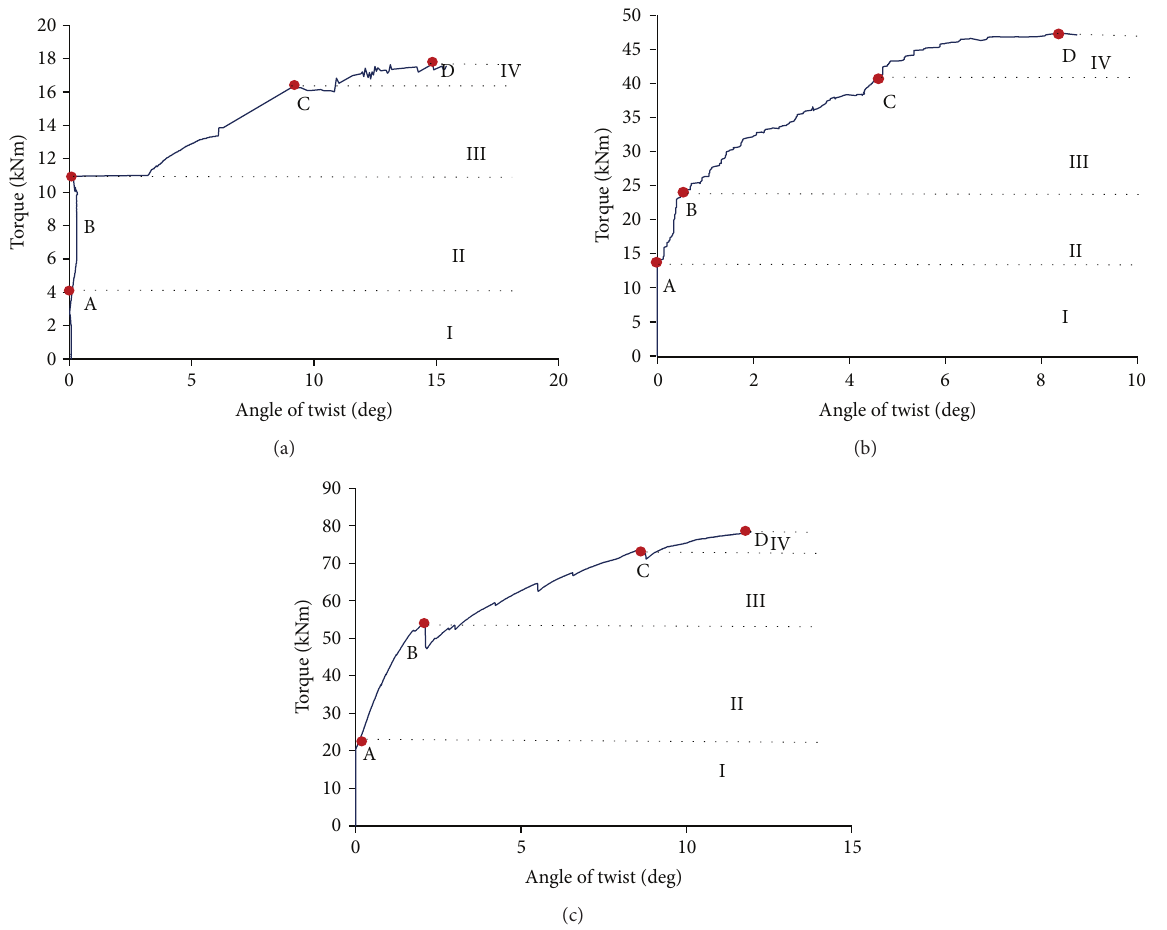
Figure 5: Torque angle of twist: (a) single cell section girder, (b) double cell section girder, (c) and triple cell section girder.